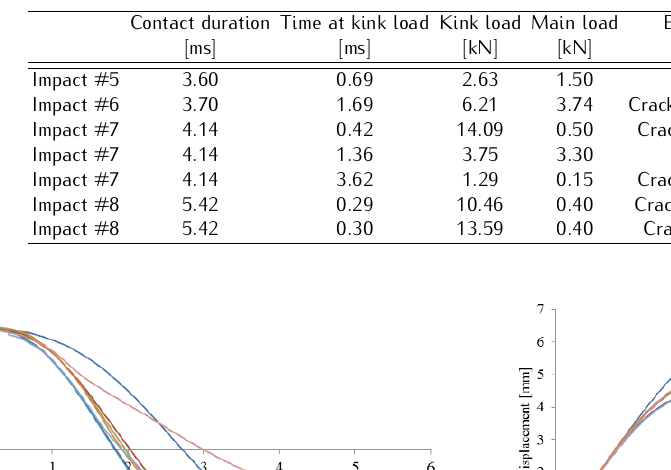
Table 2. Observed kink loads and estimated damage types.